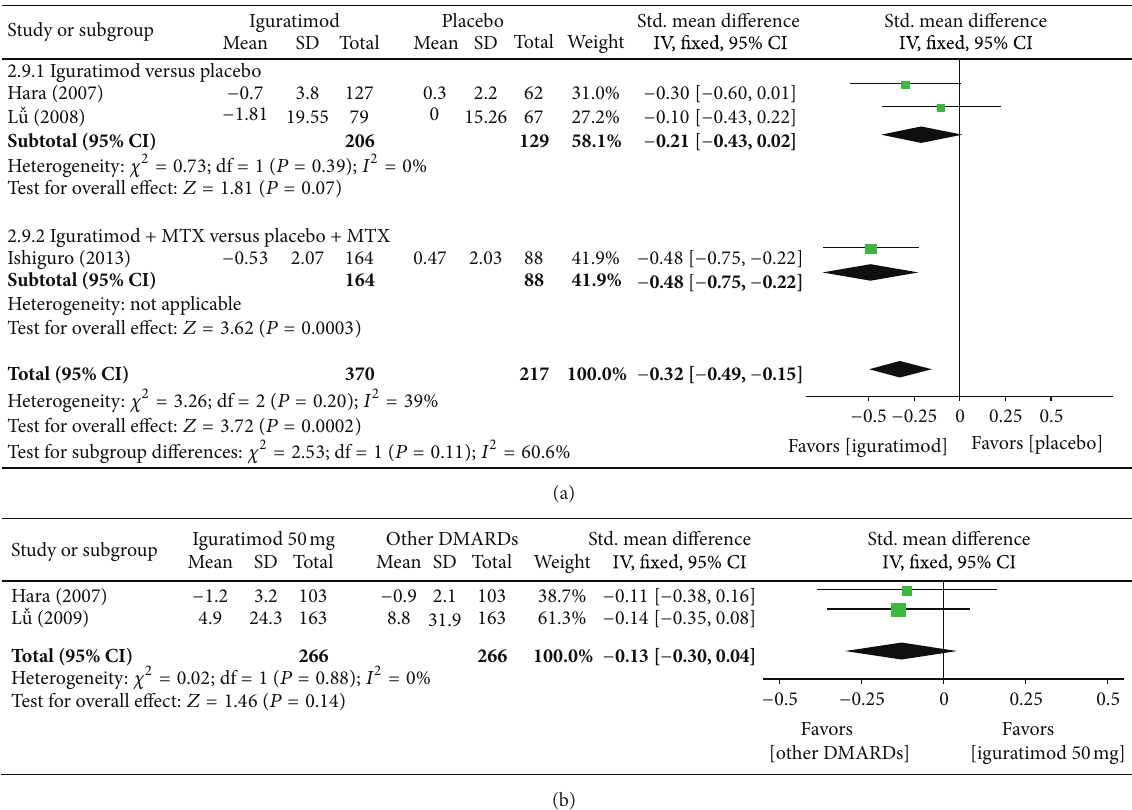
Figure 11: (a) Comparison of CRP score between iguratimod and placebo groups. (b) Comparison of CRP score between iguratimod and other DMARDs (MTX and SASP)